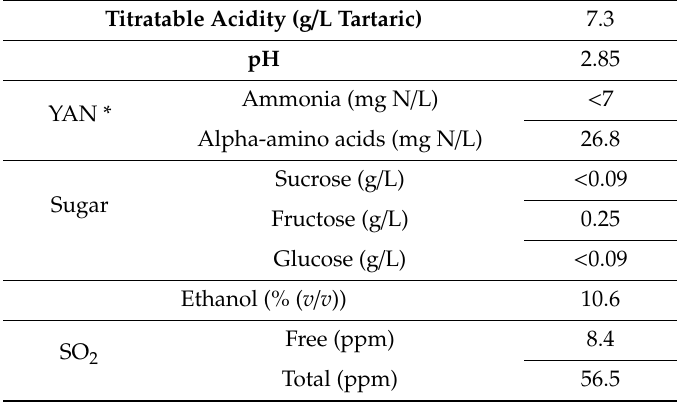
Table 1. Chemical composition of the Riesling base wine.